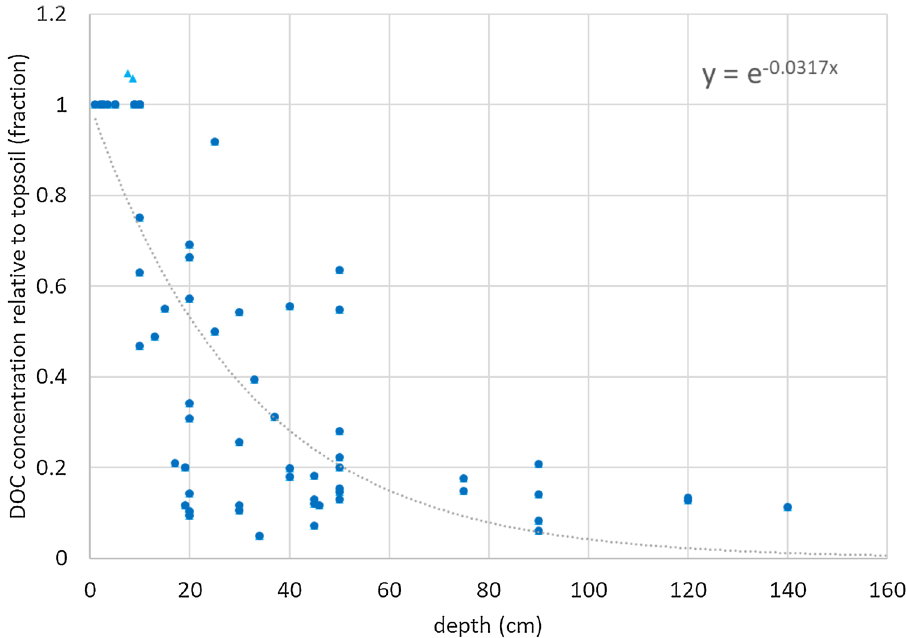
Fig. 9 Subsoil DOC concentration (mg C L −1 ) data distributed over horizon classes (n = 234, 82% of all subsoil DOC concentration data). Laboratory incubation data are excluded (n =7). Values for classes ‘O’ (n = 1) and ‘groundwater’ (n = 1). Two high peat values (372.1 and 222.5 mg C L −1 ) are not shown but included in the distri-